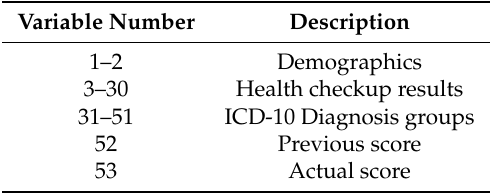
Table 2. Patients